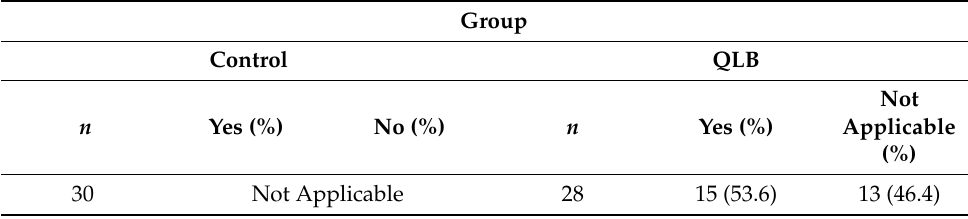
Table 6. Answer to question no. 8 from the survey. If it was not your first cesarean section in your life and you had a quadratus lumborum block (QLB), do you evaluate pain management better after surgery?